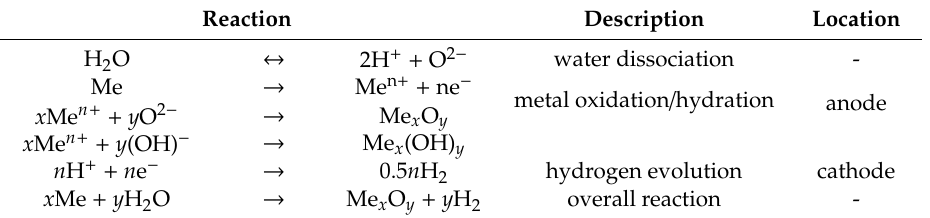
Table 2. Generalized chemical reactions proceeding during oxide or hydroxide layer formation.